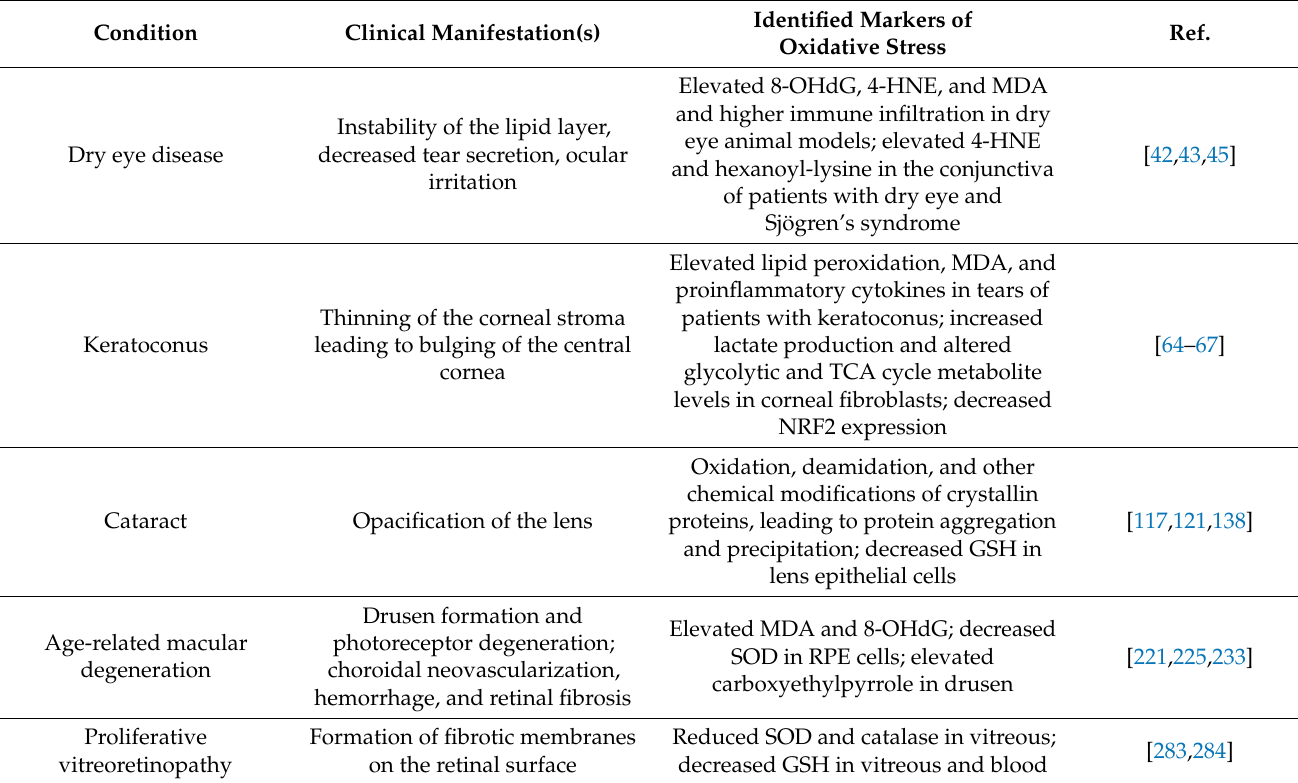
Table 2. Summary of key findings associating oxidative stress with pathologies affecting the anterior and posterior segments of the eye (Abbreviations: electron transport chain (ETC); reduced glutathione (GSH); 4-hydroxynonenal (4-HNE); malondialdehyde (MDA); nuclear factor-erythroid 2 related factor 2 (NRF2); 8-hydroxy-2-deoxyguanosine (8-OHdG); retinal ganglion cells (RGCs); retinal